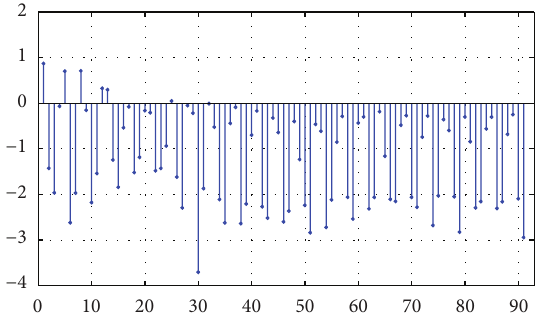
Figure 10: Absolute values of the coefficients 𝛼 𝑛 employed for approaching the boundary condition 𝑢| Γ = 𝑒 −𝑥𝑦 , utilizing the base elements {𝑢 𝑛 } corresponding to the conductivity function 𝜎 = ((𝑥 + 𝑦) 2 + 0.1) −1